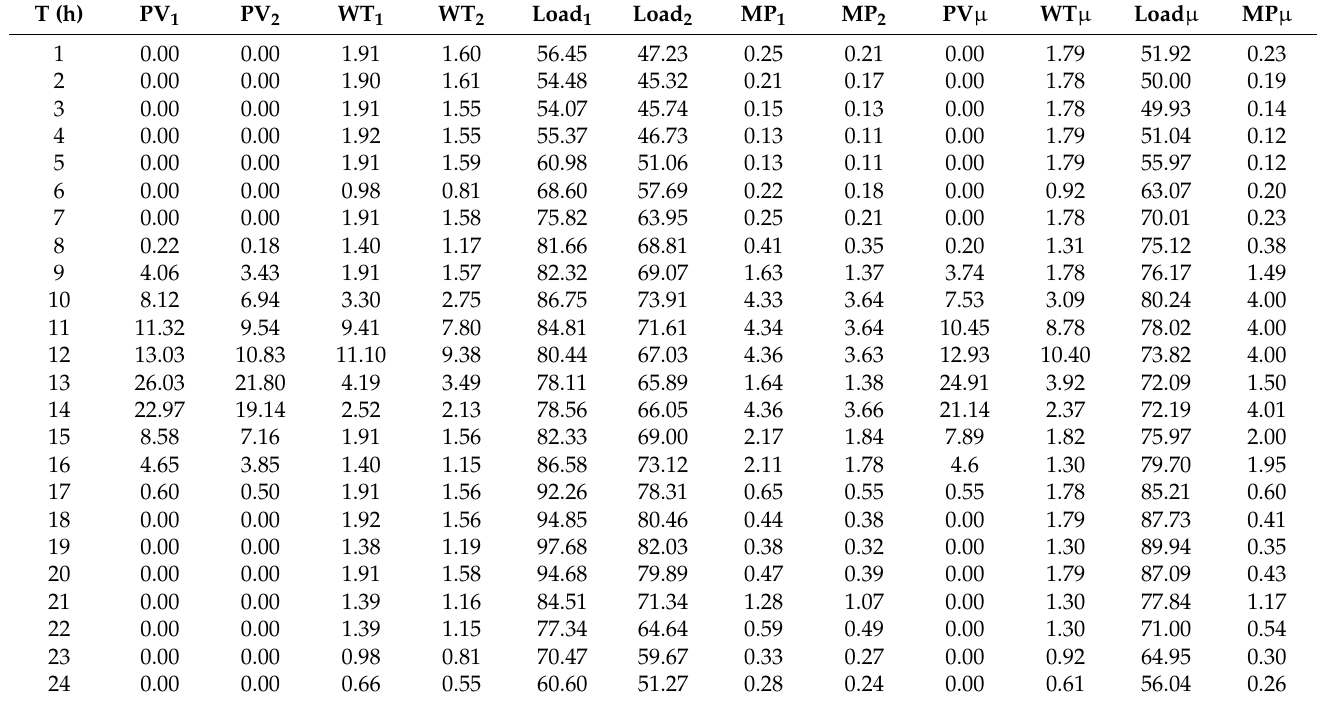
Table 11. The concentrations of the input variables used for EM problem in Case 3.